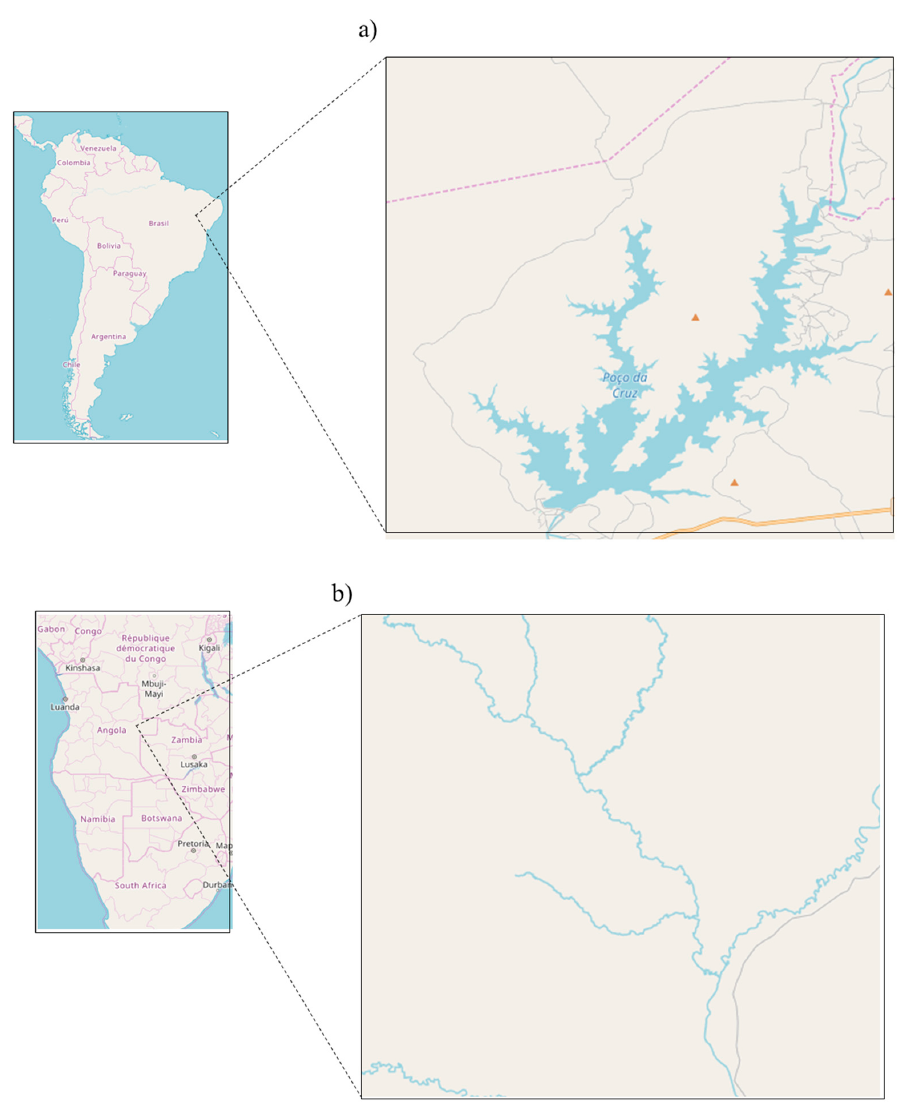
Figure 1. Example of regions of the world with poor coverage of OSM data but where water features are already represented: ( a ) Brazil and ( b ) Angola.